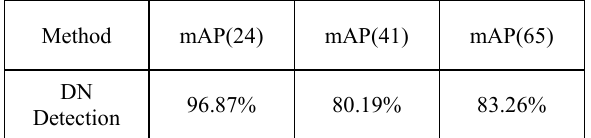
Table 4. The generalization ability test result for DN